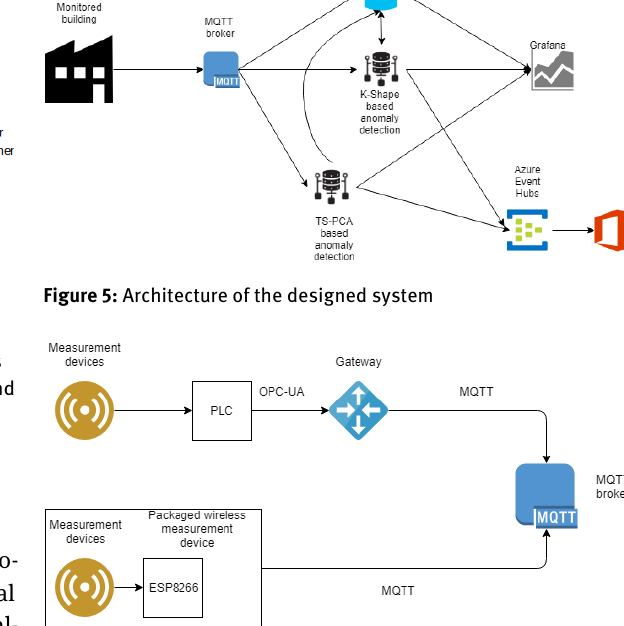
Figure 6: Main communication protocols and their